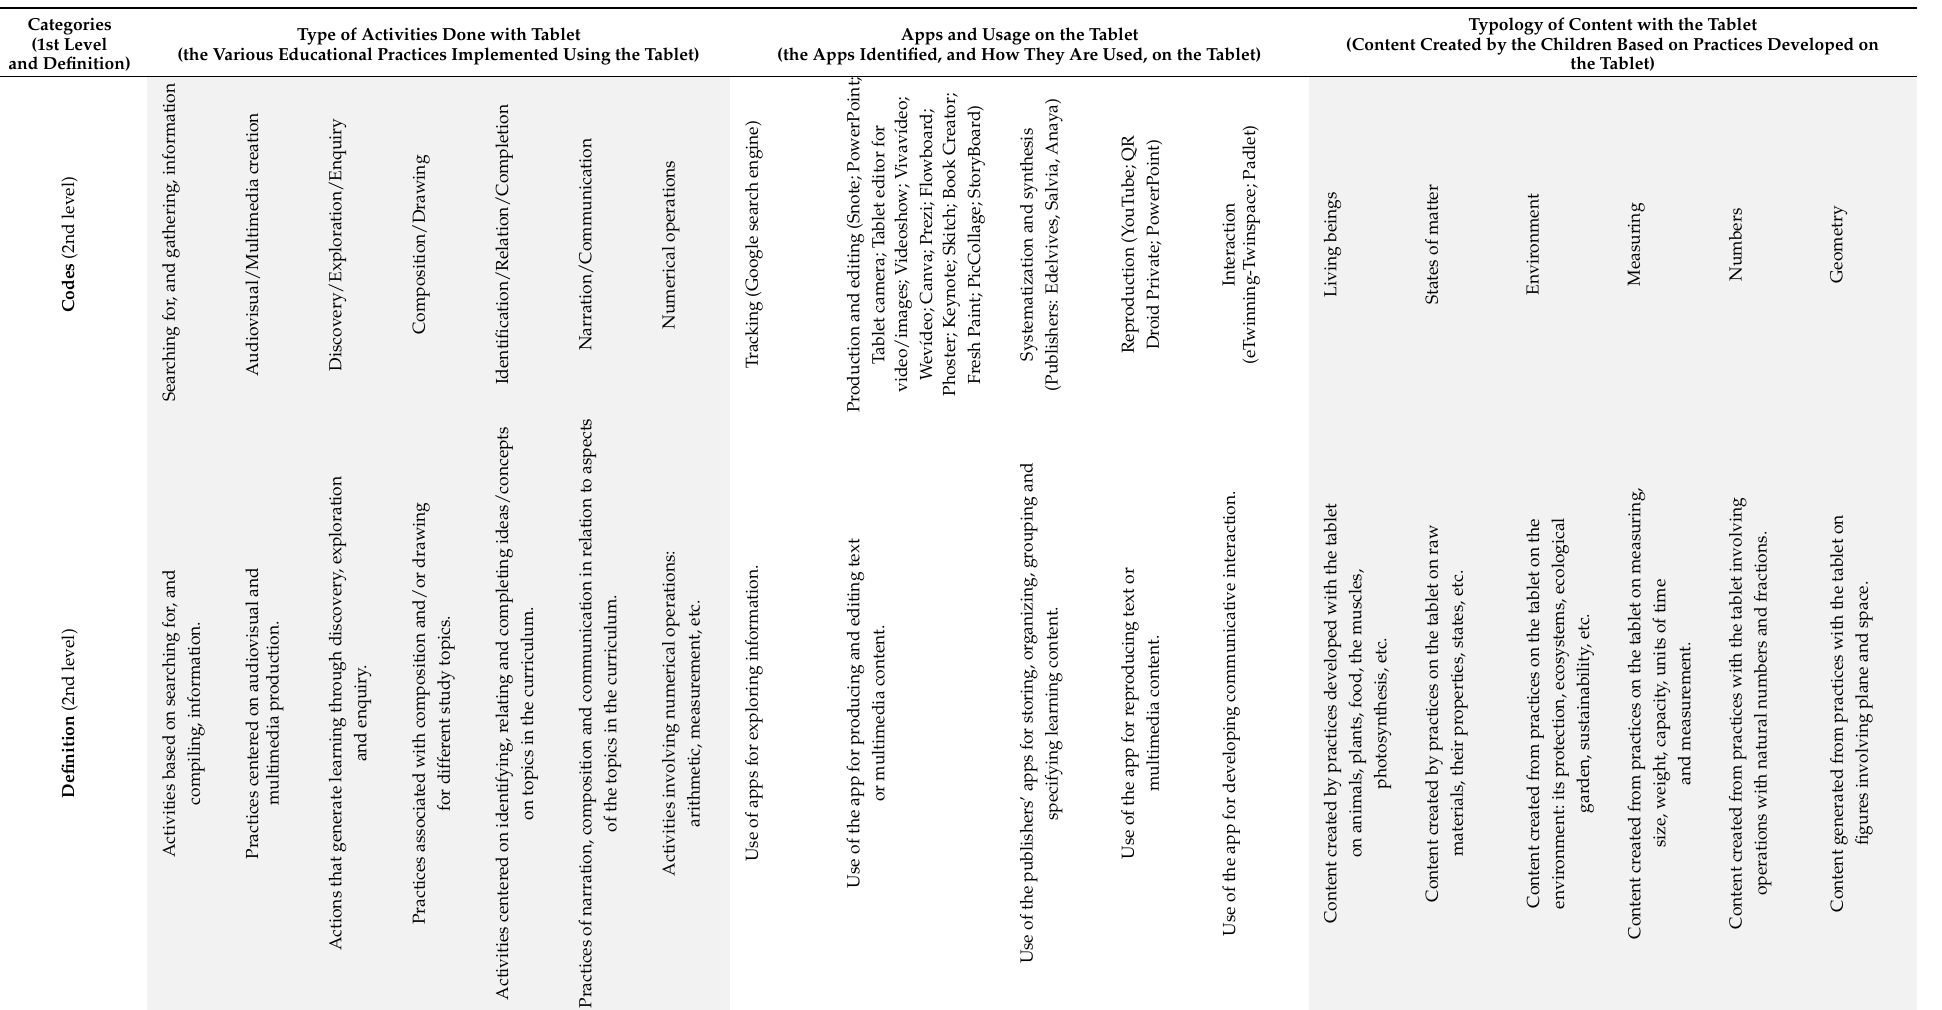
Table 1. Categories established for content